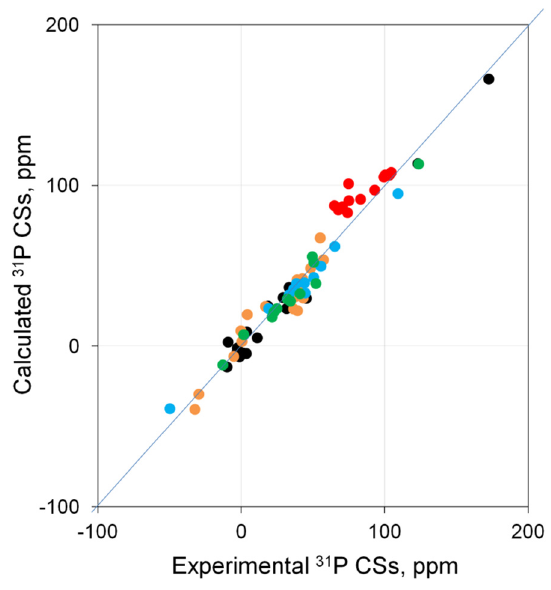
Figure 1. Correlation of calculated (PBE0/{6-311G(2d,2p); Pd(SDD)}//PBE0/{6-31+G(d); Pd(SDD)}) vs. experimental 31 P CSs for palladium complexes 1 – 39 . Complexes based on σ -donor ligands ( ● ), charged palladium complexes based on σ -donor ligands ( ● ), complexes containing Р = О groups ( ● are the Р = О phosphorus, ● are other phosphorus atoms in these types of complexes), and complexes based on π -donor ligands ( ● ).